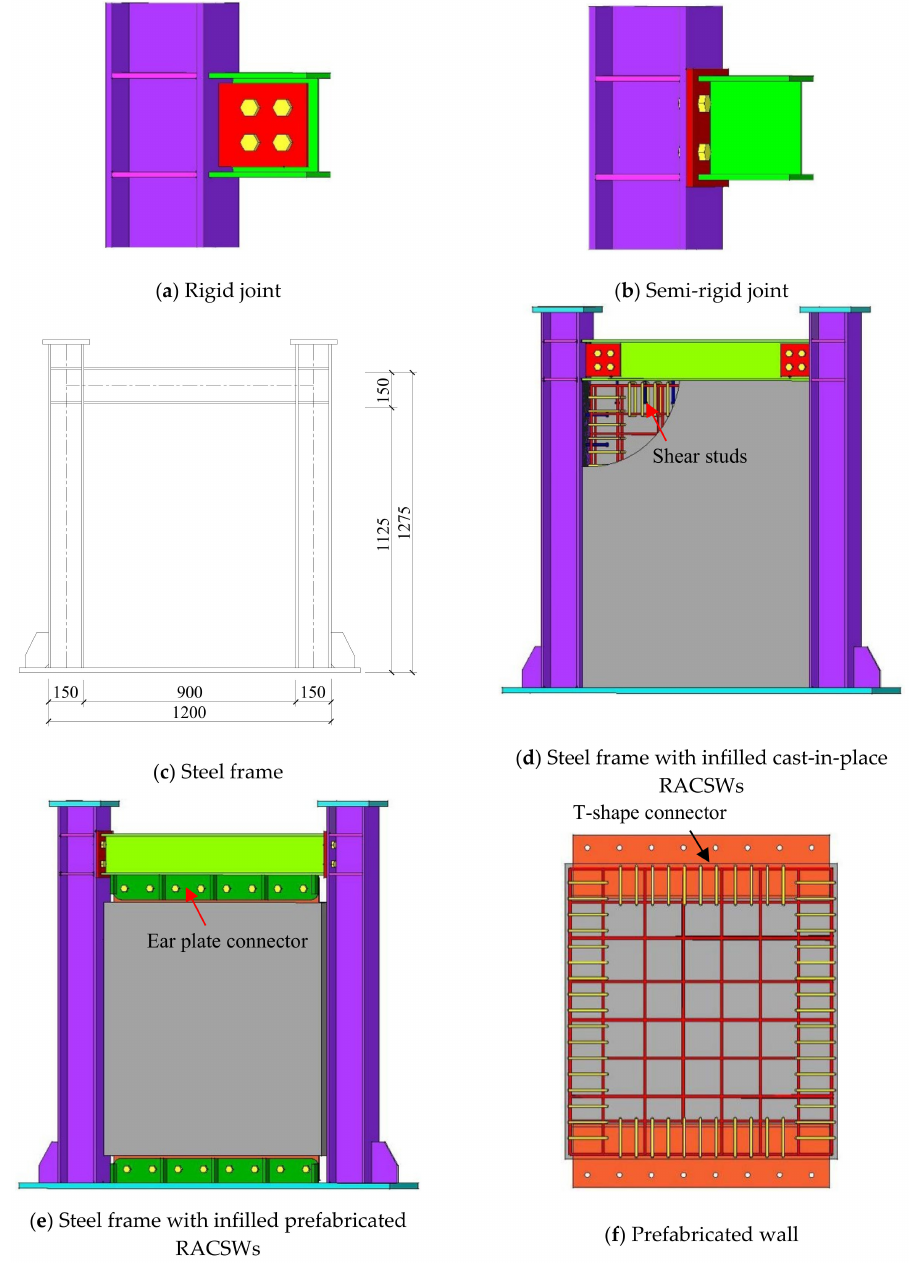
Figure 1. Dimensions and details of